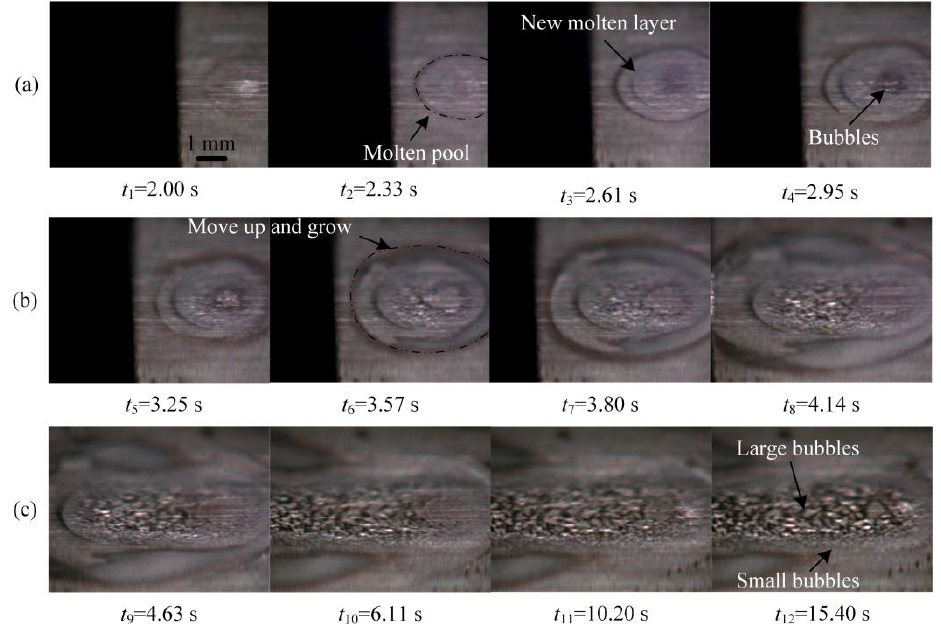
Figure 2. High-speed camera images of the bubble formation and movement. ( a ) Formed molten pool and bubbles, ( b ) Growth of the molten layer and bubbles fluctuated, ( c ) Solidification process.